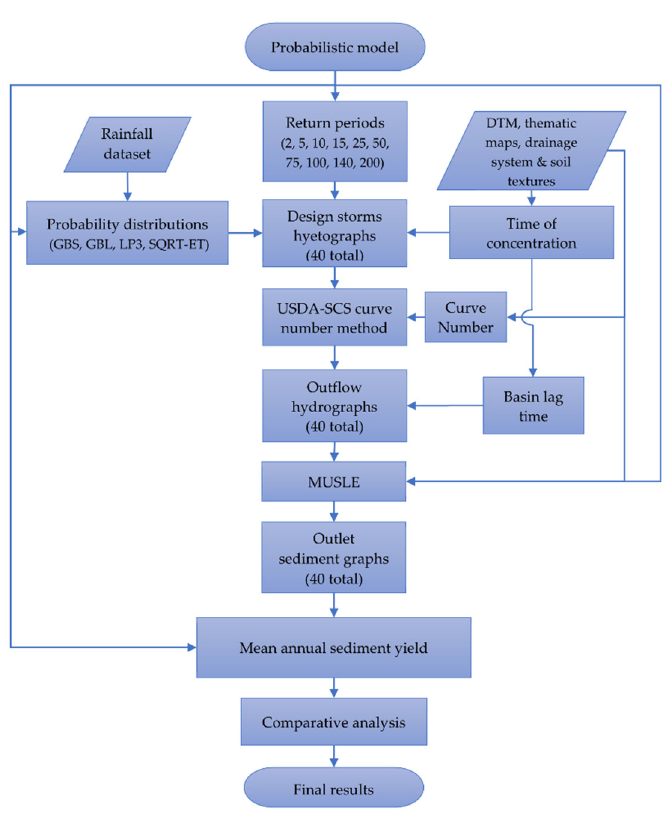
Figure 2. Flow chart of the applied methodology. Only the main operations have been represented.